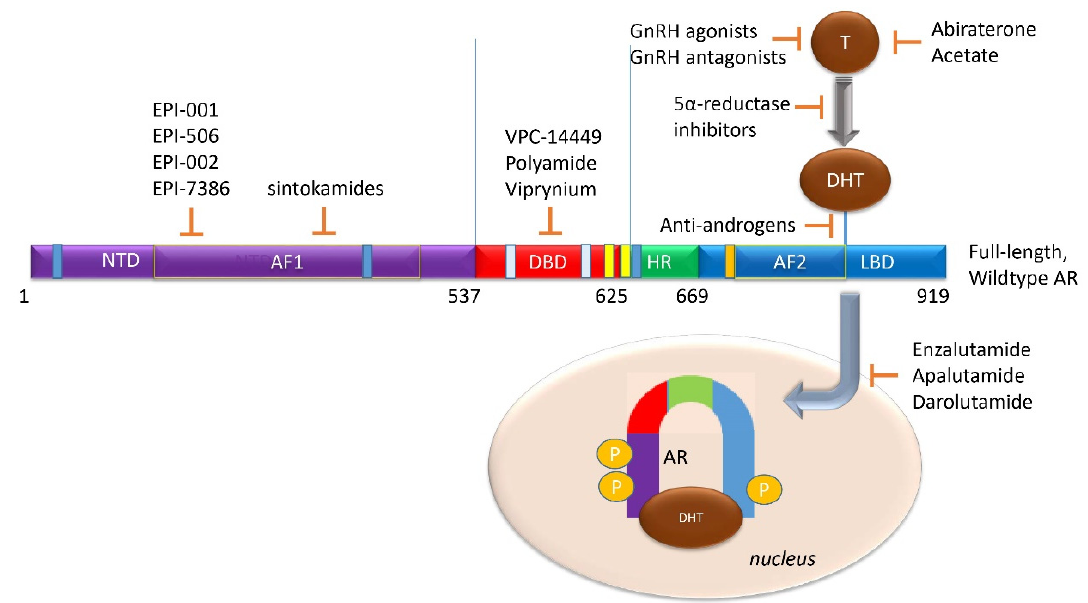
Figure 6. Current AR-targeted Treatments in clinical use or in development. ( LBD Targeting ) GnRH agonists (like leuprolide or goserelin), in addition to androgen biosynthesis inhibitors (like abiraterone acetate), block testosterone-mediated activation of the AR. 5- α reductase inhibitors, (like finasteride or dutasteride), and may have a role in a combination therapy to prevent testosterone conversion to its higher affinity form, DHT. Antiandrogens (like bicalutamide, nilutamide, and flutamide) are competitive inhibitors of AR ligand-binding. Direct AR inhibitors enzalutamide, apalutamide, or darolutamide, block androgen binding to the AR LBD to prevent AR activation. ( NTD and DBD Targeting ) No current clinical therapy exists to block either the AR-NTD or AR-DBD. However, several are now in development, such as the NTD-directed EPI-001 series or the DBD- targeted VPC-14449.